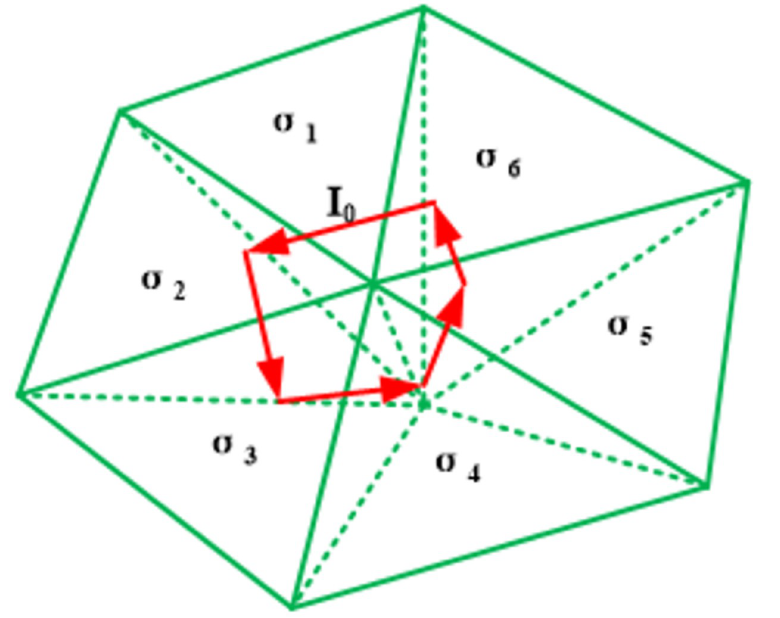
Fig 4. Position relation of sources in the mesh.